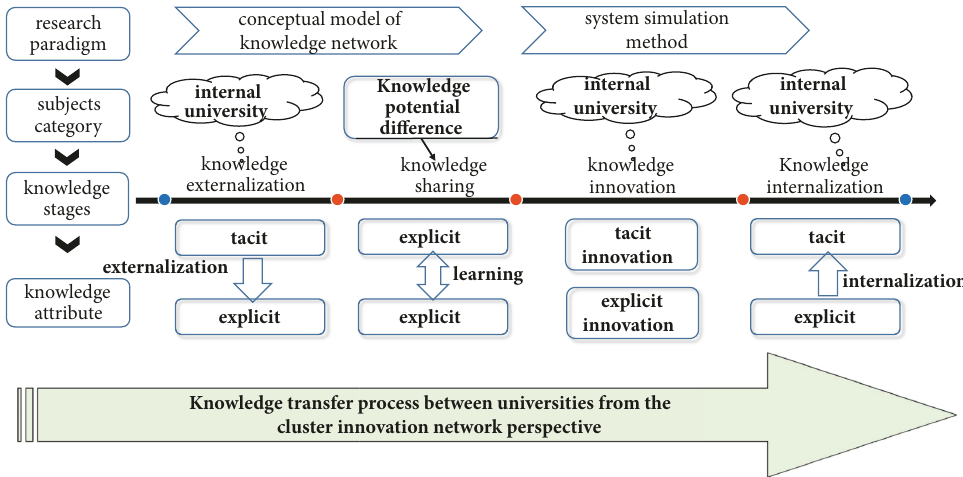
Figure 1: Universities’ knowledge transfer process model from the cluster innovation network